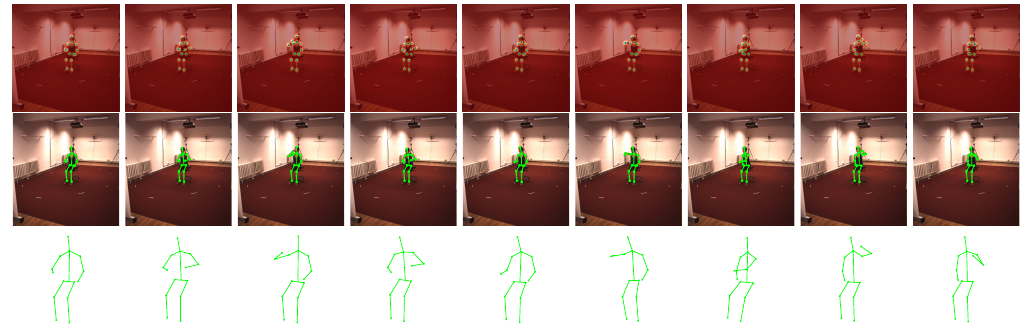
Figure 7. Evaluation of marker-less method on ’eating’ sequence in Human3.6M datasets. The visualization of results from nine selected frames are shown from left to right. For each frame, the heightmaps of all the joints are displayed together in the first row, the projection of our reconstructed 3D human structure is plotted in the second row and the reconstructed 3D structure is shown in the bottom